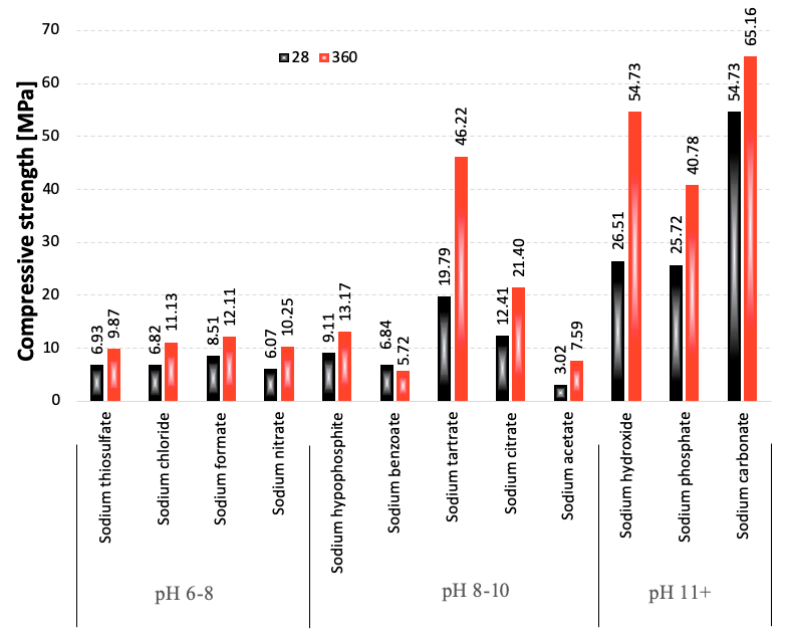
Figure 4. Compressive strength of the pastes after 28 days of curing, ranked according to the pH of the activator solutions.